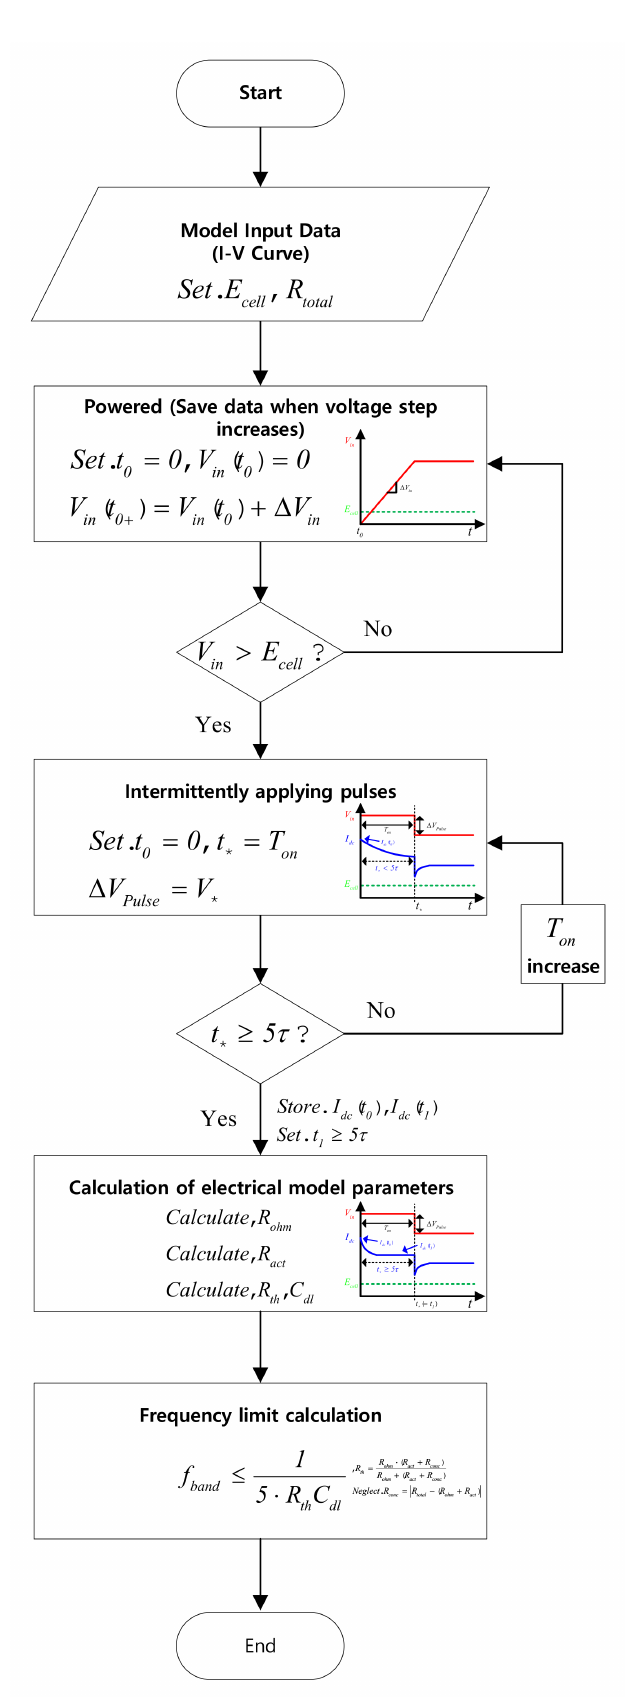
Figure 11. Flowchart of electrical